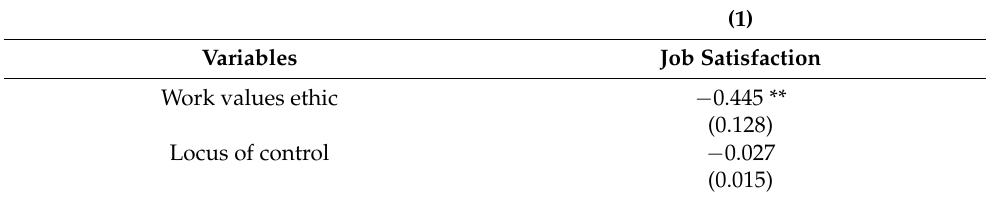
Table 4. Locus of control, work values ethic and job